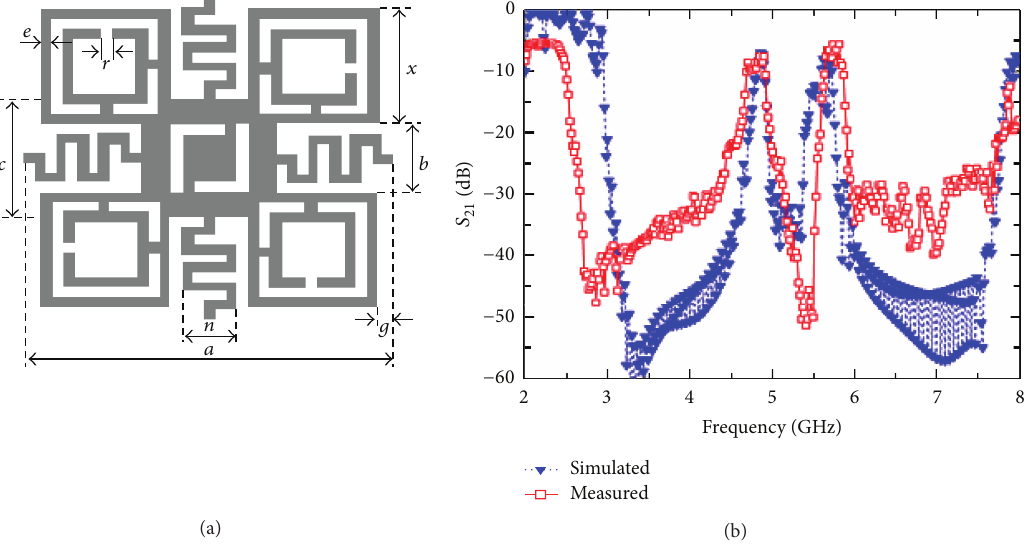
Figure 12: A triple band EBG: (a) unit cell and (b) transmission characteristics ( 𝑆 21